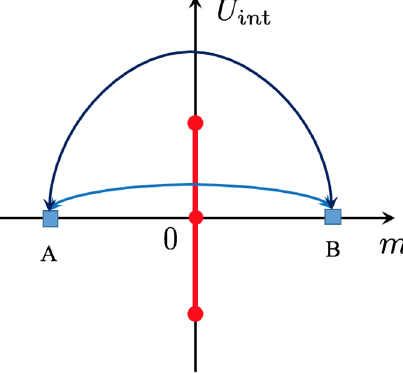
FIG. 6. A schematic phase diagram for unnecessary phase